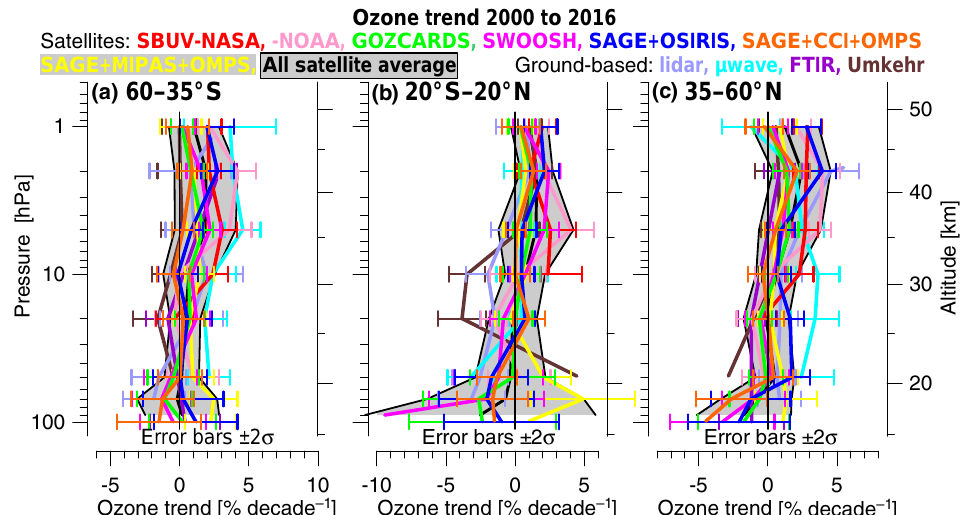
Figure 4. Vertical profiles of 2000 to 2016 ozone trends, obtained by 2-step multiple linear regression (see text), for different merged satellite and ground-based station data sets. Results are for the zonal bands 60 to 35 ◦ S (a) , 20 ◦ S to 20 ◦ N (b) and 35 to 60 ◦ N (c) . For the 60 to 35 ◦ S zonal band, FTIR data from Wollongong (34.4 ◦ S), and Umkehr data from Perth (34.7 ◦ S) are included. For the 35 to 60 ◦ N band, lidar data from Table Mountain (34.4 ◦ N) and FTIR data from Izaña (28.3 ◦ N) are included. SBUV and Umkehr data are not shown at or below the 50hPa level. Black lines and grey shading show the average trend and ± 2 σ SDs of the seven satellite-based trends (see also Fig. 5 and text).